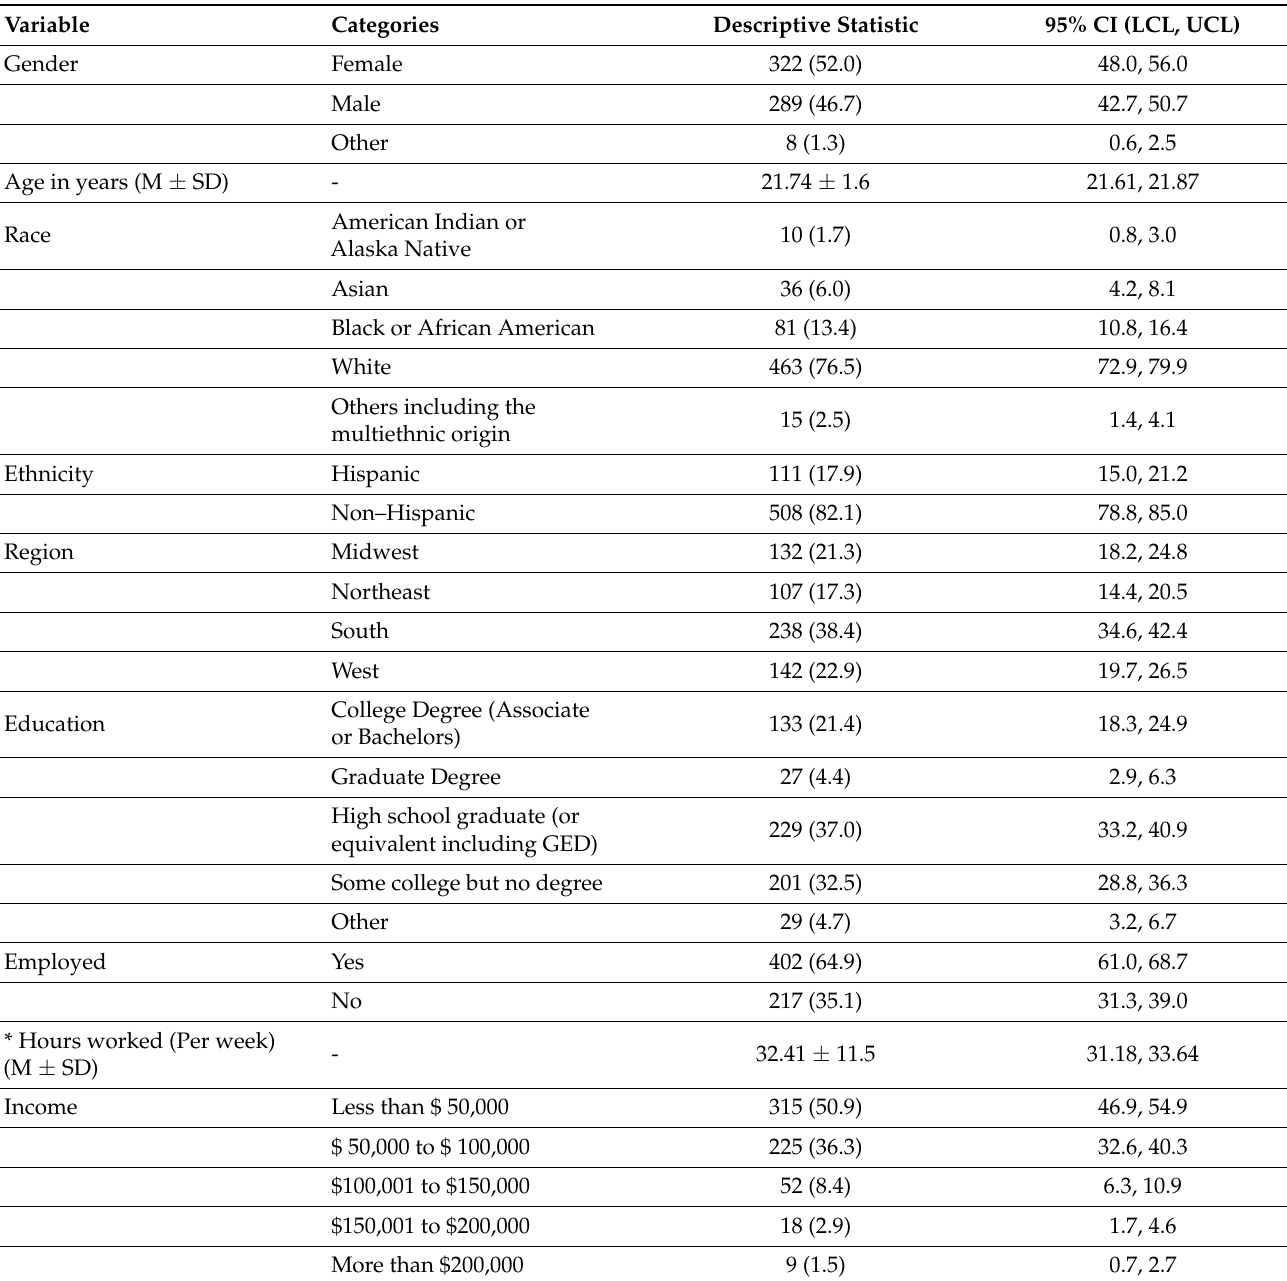
Table 2. Socio-demographics characteristics of the sample engaged in vaping (N =